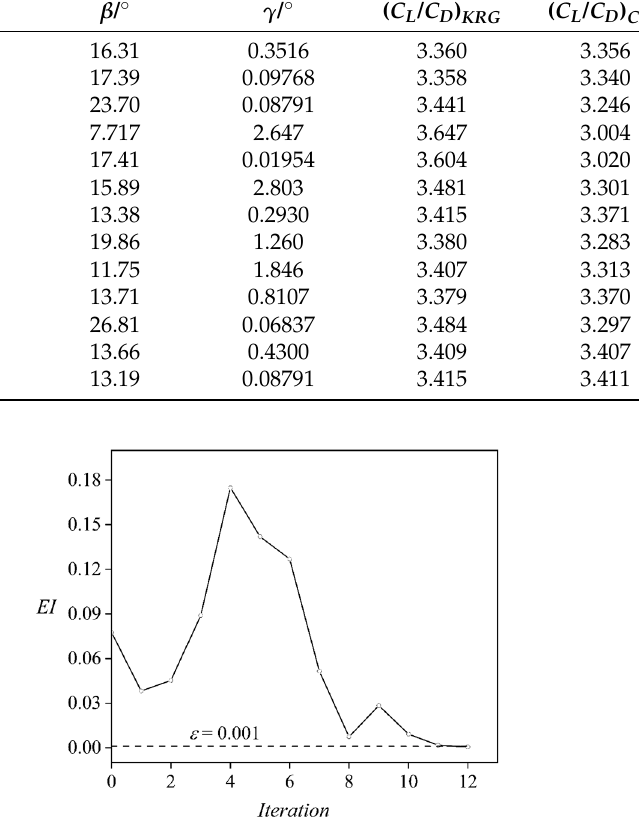
Figure 4. The EI Maximum of the dynamic Kriging model during the iterations. The dotted line indicates the EI threshold for convergence.